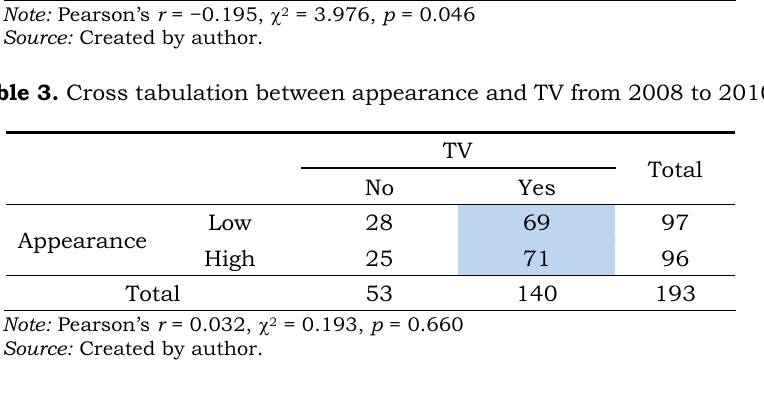
Table 2. Cross tabulation between appearance and TV from 2005 to 2007 TV Total No Yes Low 55 14 69 Appearance High